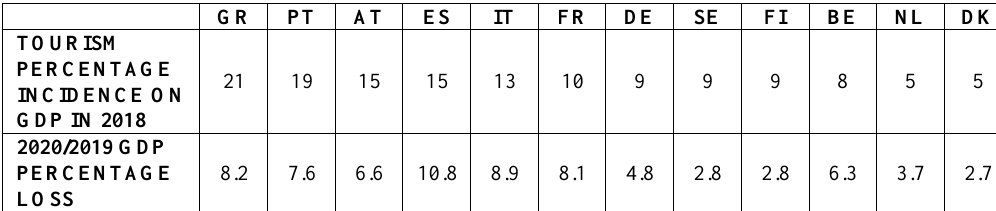
Table 1: Tourism % Incidence on GDP in 2018 and 2020/2019 GDP % Loss GR